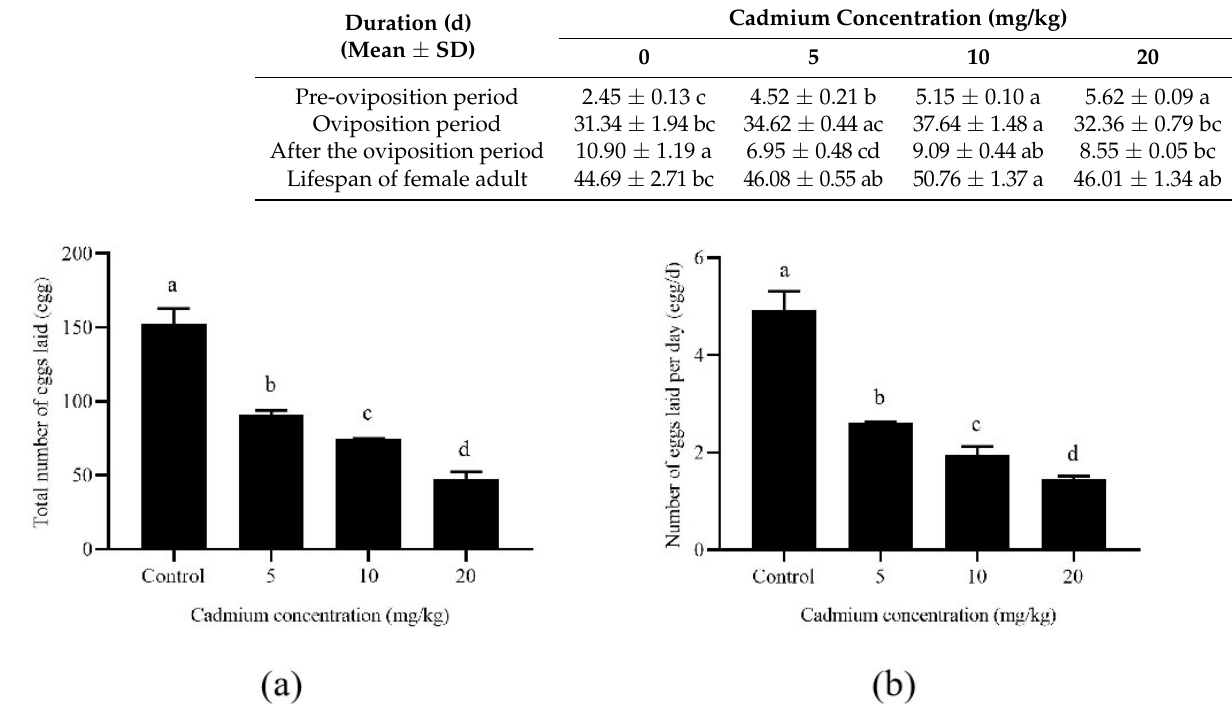
Figure 2. The number of eggs laid per Aleuroglyphus ovatus female adult under different Cd concentration stress. ( a ) The total number of eggs; ( b ) The Number of eggs laid per day. Results are expressed as mean ± SD. Different lowercase letters indicate significant differences among control and treatment groups at different cadmium concentrations ( p < 0.05).